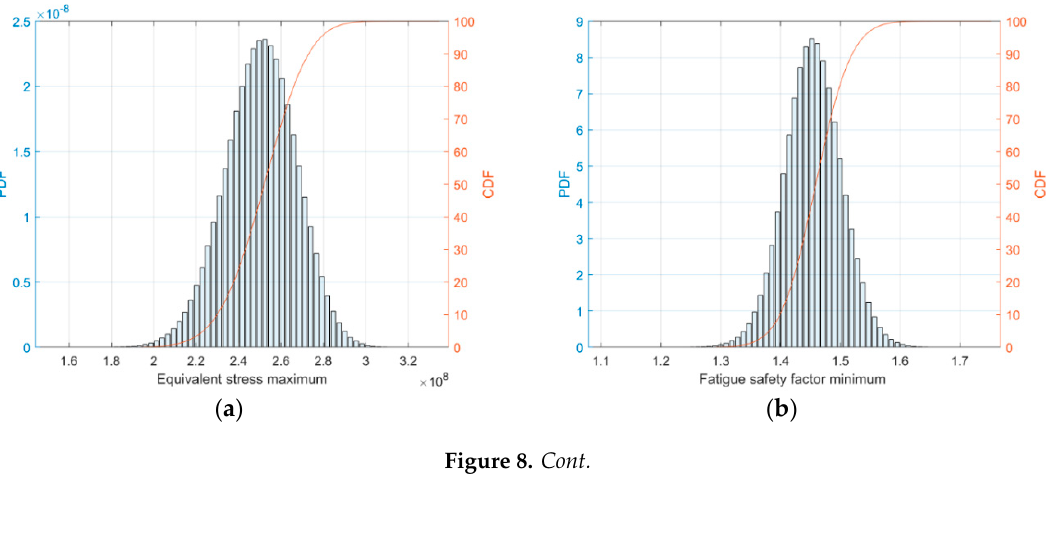
Table 8. Stochastic variables.